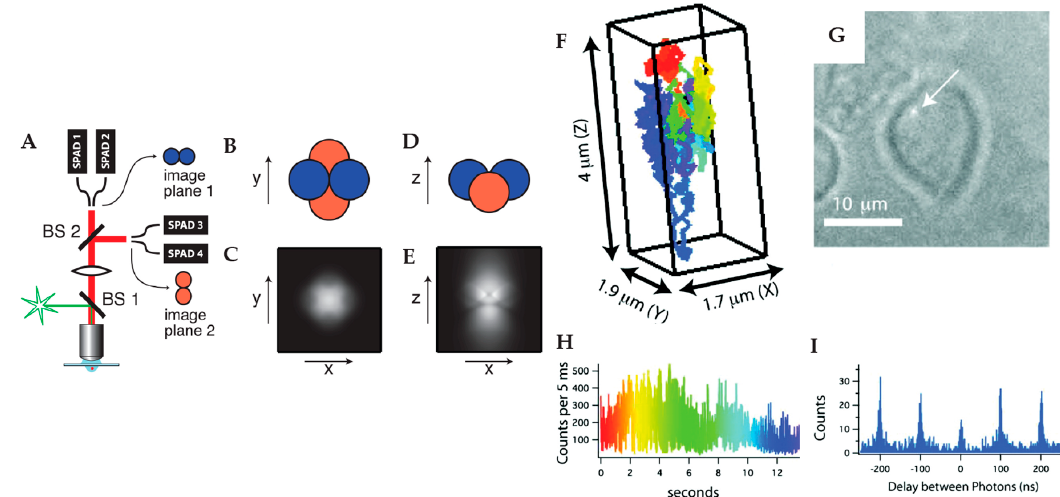
Figure 4. Tetrahedral detection active feedback 3D tracking. ( A ) Schematic of experimental setup. BS: beamsplitter; SPAD: single-photon counting avalanche photodiode. ( B , D ) Schematic of the sample volume viewed along Z ( B ) and Y ( D ) axis, in which the four balls represent the sample volumes of four SPC-APDs. ( C , E ) Total fluorescent intensity in the Z = 0 plane ( C ) and Y = 0 plane ( E ). Reprinted from reference [67], with the permission of AIP Publishing. ( F ) 3D trajectory of a single quantum dot labeled high-a ffi nity immunoglobin E receptor (IgE-Fc ε R) in a live cell. The rainbow color from red to blue indicates time. ( G ) Image of cell and the actively tracked receptor (white arrow). ( H ) Fluorescence intensity of the quantum dot probe as a function of time. ( I ) Photon pair correlation measurement shows fluorescence photon antibunching, indicating a single quantum emitter. Reprinted with permission from reference [70]. Copyright 2010 American Chemical